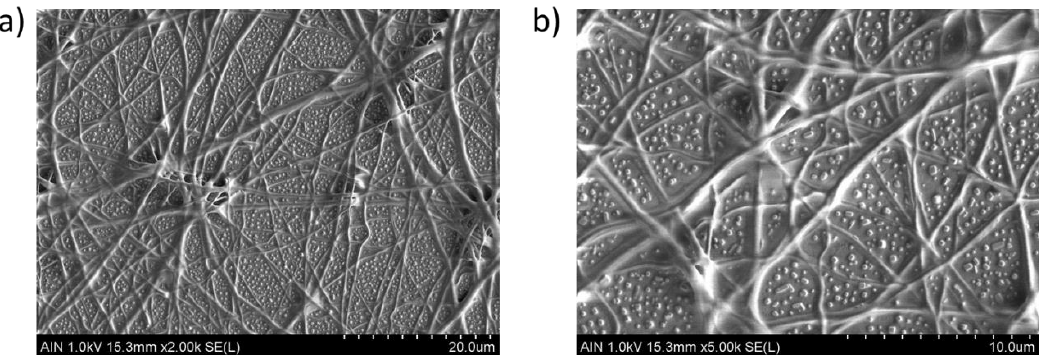
Figure 9. SEM images of the electrospun fibers after the CVD-silanization process for a scale bar of ( a ) 20 µm and ( b ) 10 µm, respectively.